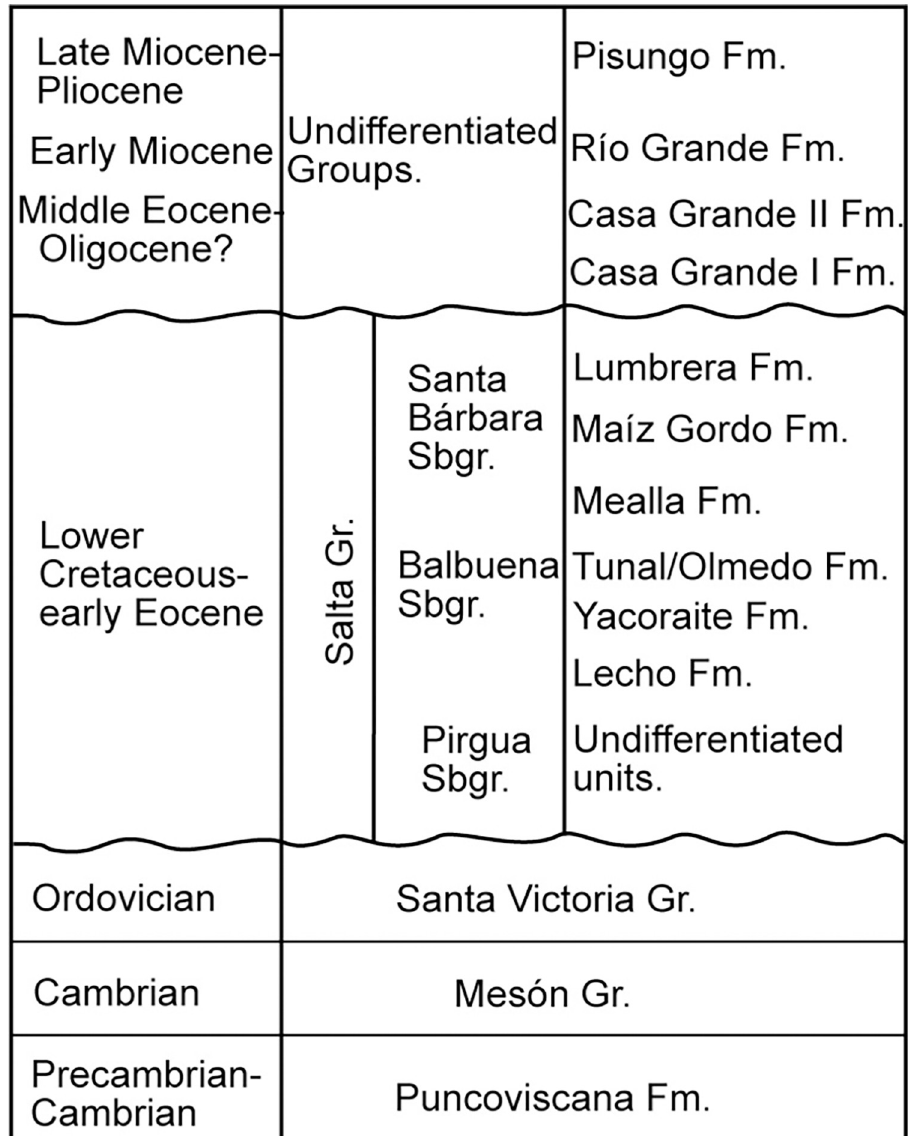
Fig 3. Stratigraphic chart of the Groups/Formations recognized in the region. Note the stratigraphic relationship between the Casa Grande I Fm. and other units used for comparison in the present analysis (Tunal Fm./Olmedo Fm., Mealla Fm., Maı´z Gordo Fm., and Lumbrera